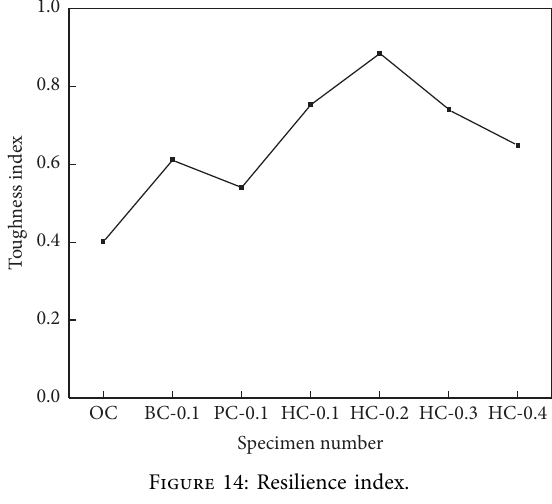
Figure 14: Resilience index.